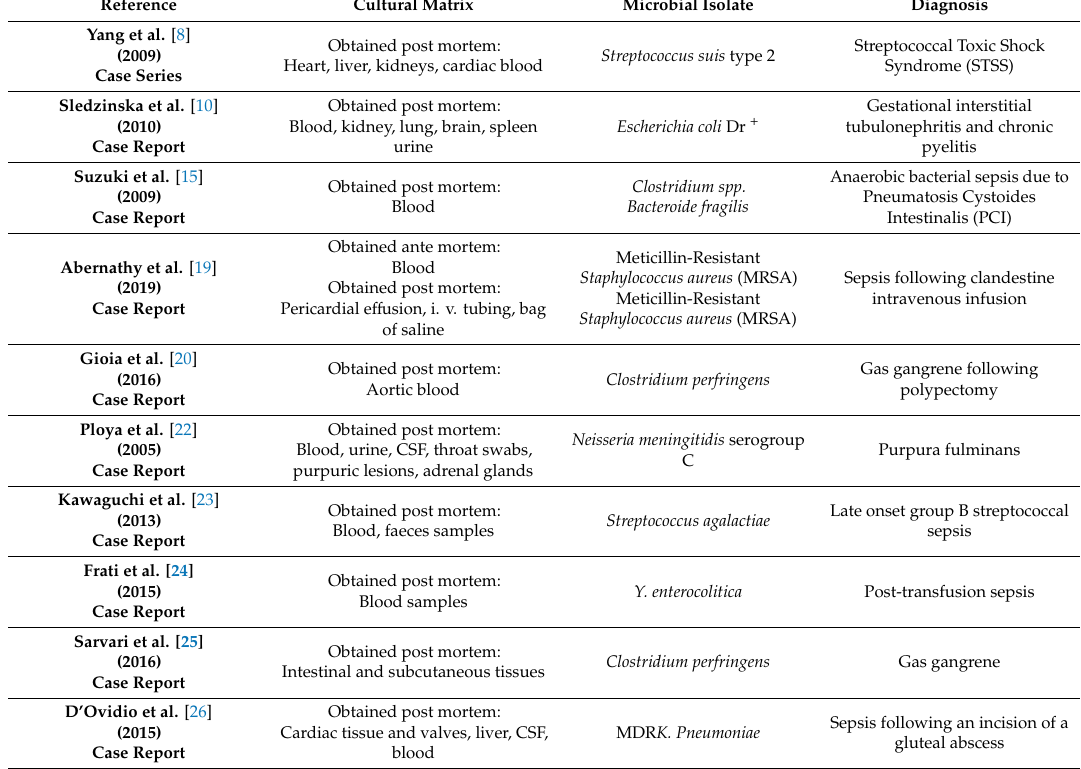
Table 2. Works discussing the post-mortem role of cultural investigations for the aetiological diagnosis of